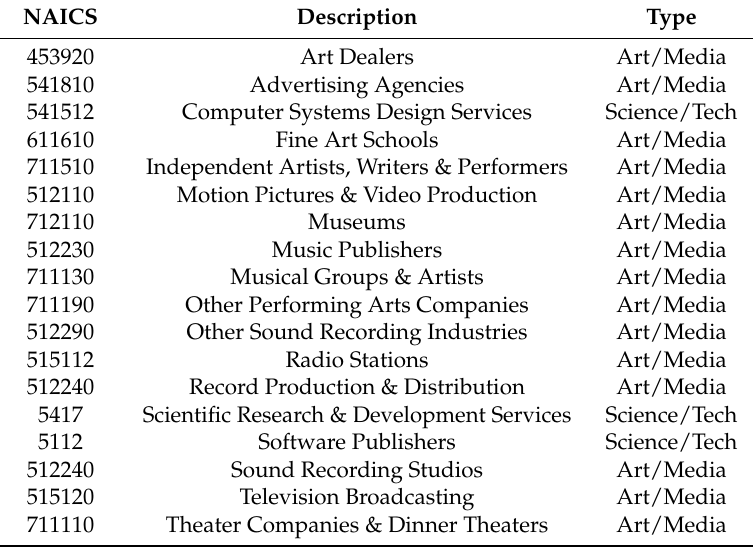
Table 1. Creative industry classes used in this